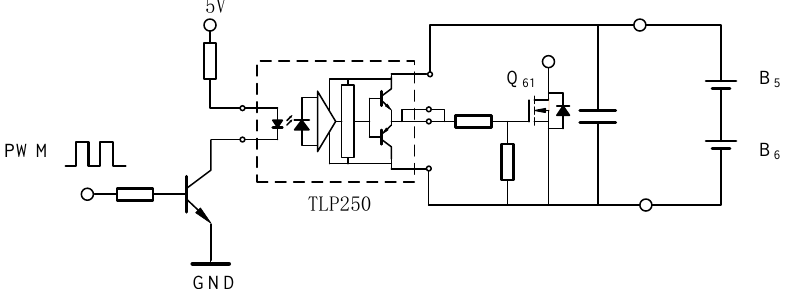
Figure 4. Optocoupler isolated driving circuit for the switches whose source is connected to the cell directly.